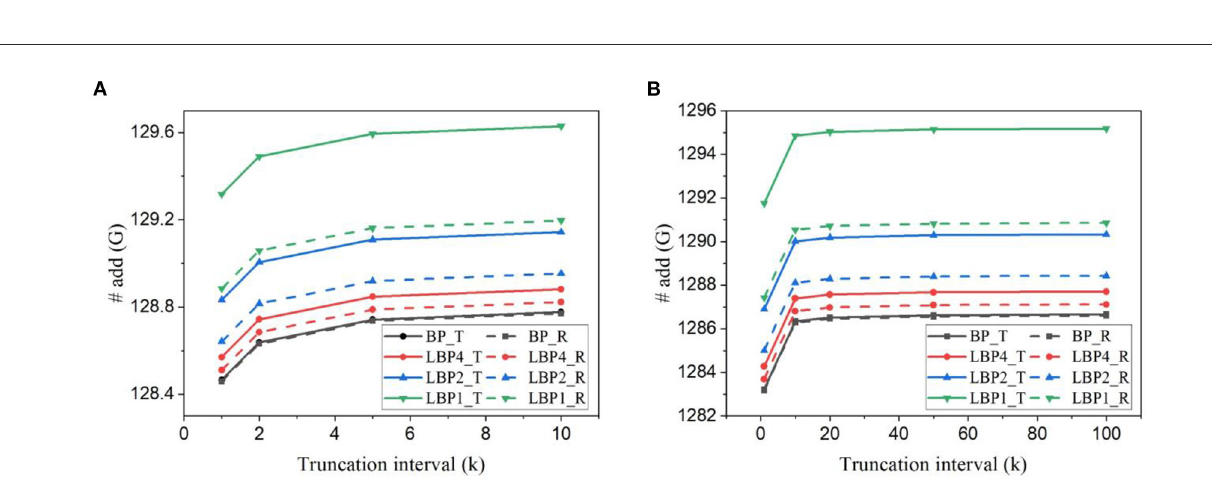
FIGURE12 Number of additions estimated for training AlexNet (A) on CIFAR10 dataset and (B) on CIFAR10-DVS